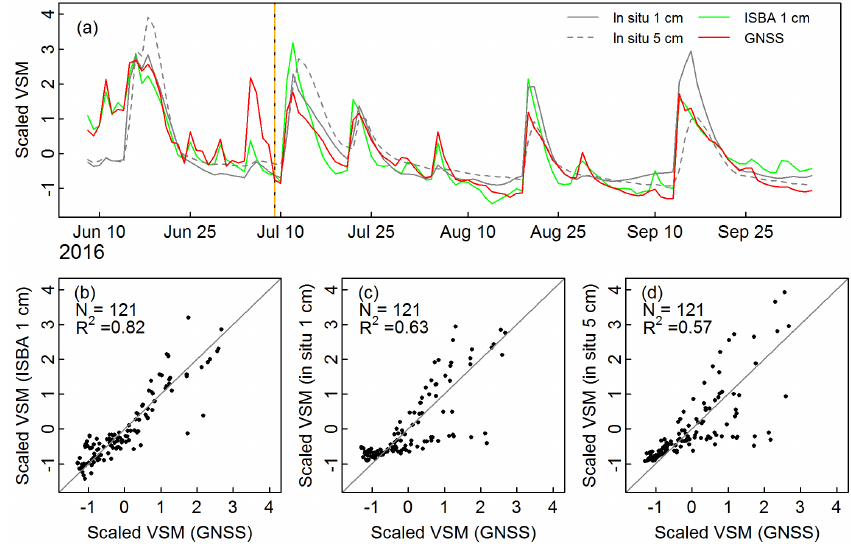
Figure 8. (a) Scaled GNSS VSM retrieval time series (red line, N = 121) using both L2C and L5 SNR data during separate TS3 and TS4, scaled ISBA 1cm simulations (green line) and scaled in situ VSM observations at 1cm (grey solid line) and at 5cm (grey dashed line). The SNR data acquired by the 3.3m antenna with 1s sampling interval were used during TS3 and TS4. The black/orange dashed line indicates the grass cutting of 9 July 2016. (b, c, d) Scatter plots of scaled ISBA VSM simulations at 1cm, scaled in situ VSM observations at 1cm and scaled in situ VSM observations at 5cm vs. scaled GNSS VSM retrievals, respectively.